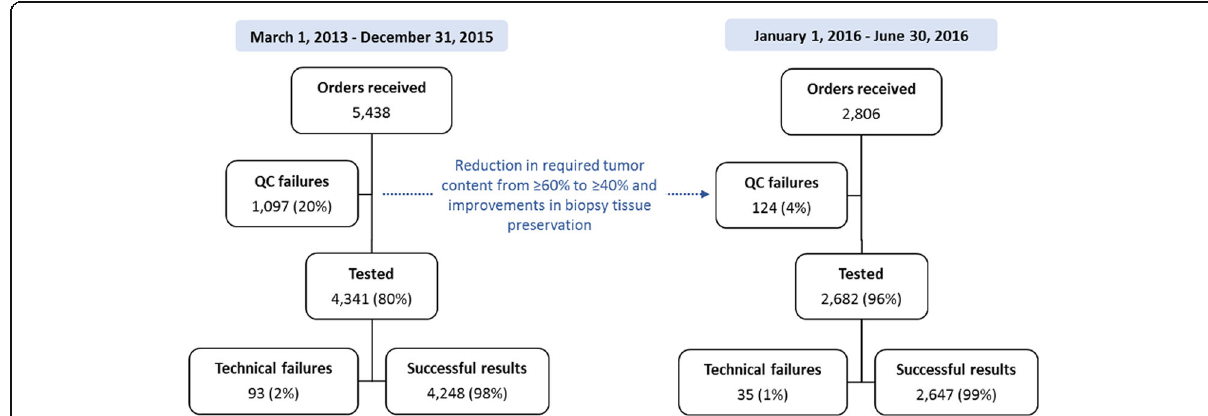
Fig. 5 Technical experience of the DecisionDx-Melanoma test for samples submitted from March 2013 to June 2016. Quality control rejections, technical failures and successfully tested samples are presented for the time periods before and after the reduction in required tumor density, implemented after successful clinical validation and through educational efforts to improve biopsy tissue preservation at the dermatopathology